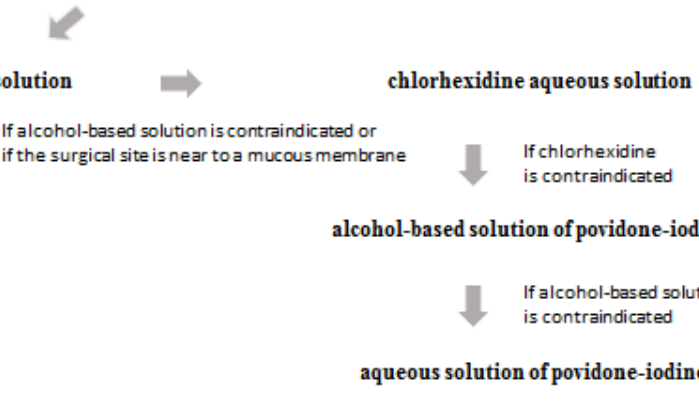
Figure 1. Antiseptic skin preparation.